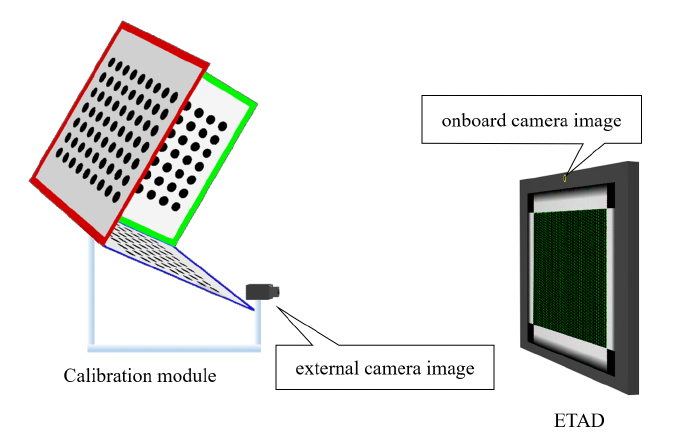
Figure 3. Overview of the calibration process using the calibration module. The calibration module consists of a 3D calibration pattern and an external camera.